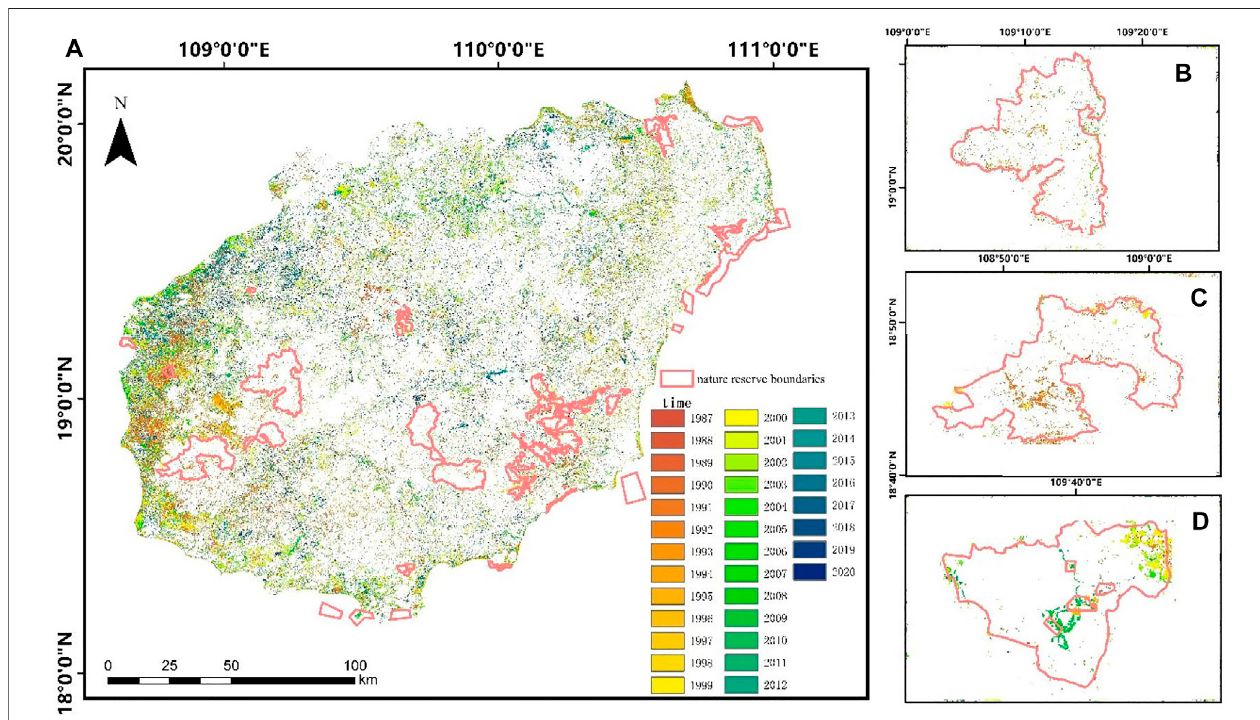
FIGURE 2 | Forest disturbance in Hainan National nature reserves from 1987 to 2020. (A) The disturbed area of forest vegetation in Hainan nature reserves from 1987 to 2020 and the change of disturbed area in different years. (B) Forest disturbance in Bawangling National Nature Reserve. (C) Forest disturbance in Jianfengling National Nature Reserve. (D) Forest disturbance in Ganshiling Provincial Nature Reserve.